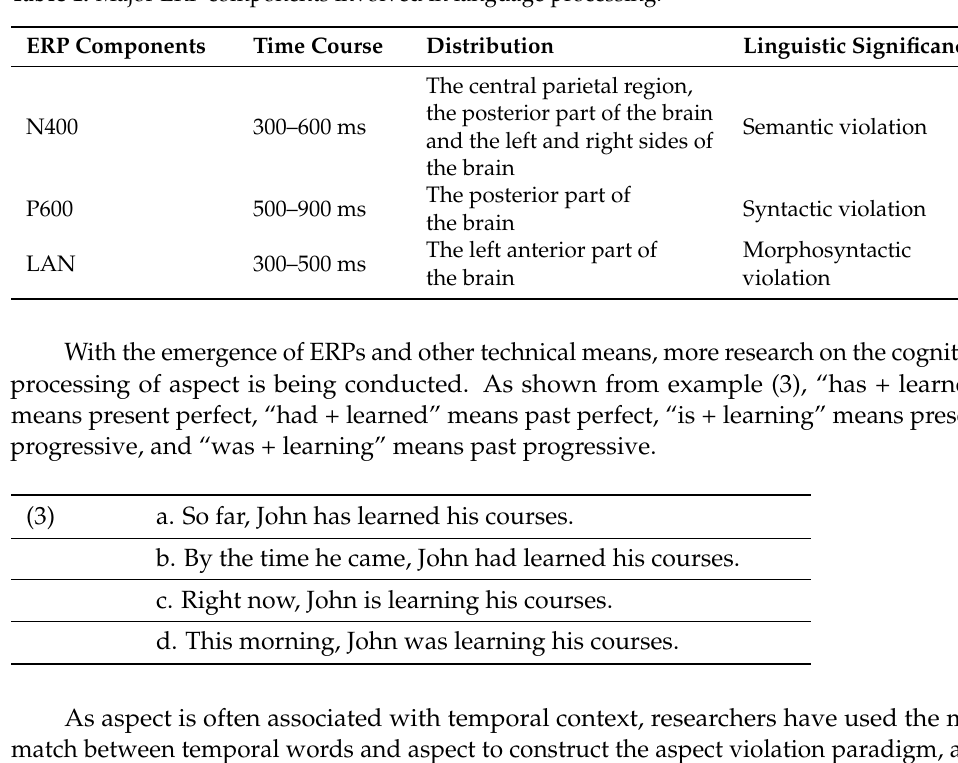
Table 1. Major ERP components involved in language